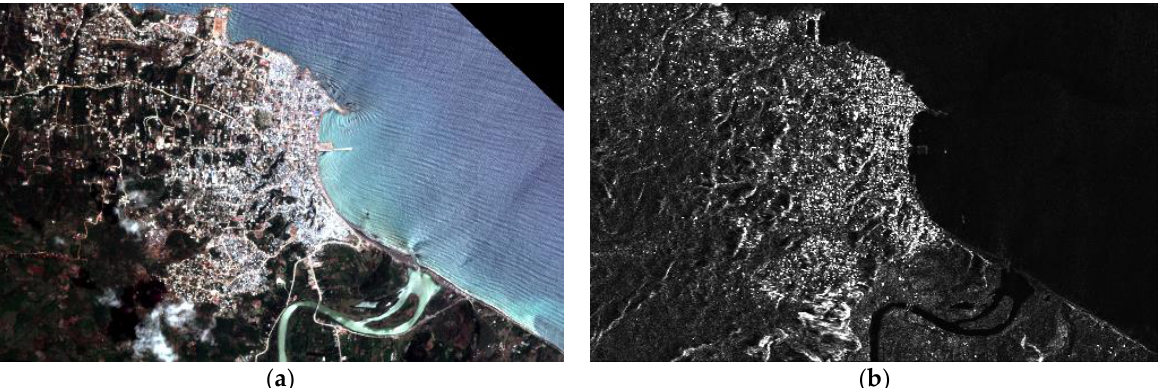
Figure 3. “Jérémie 2018” dataset: ( a ) RGB true-color composition of the multispectral Pléiades acquisition (image © CNES 2018, distribution Airbus DS); ( b ) StripMap HIMAGE SAR acquisition (COSMO-SkyMed Product © ASI—Italian Space Agency—2018. All rights reserved.).